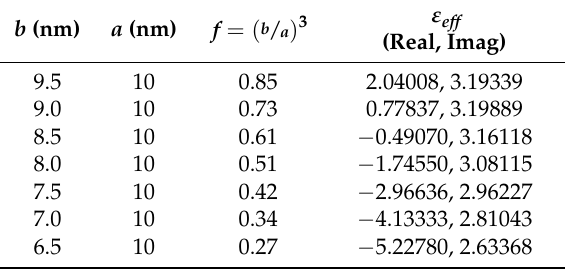
Table 3. The effective permittivity of an Fe 3 O 4 @Au core-shell for variations of f = ( b / a ) 3